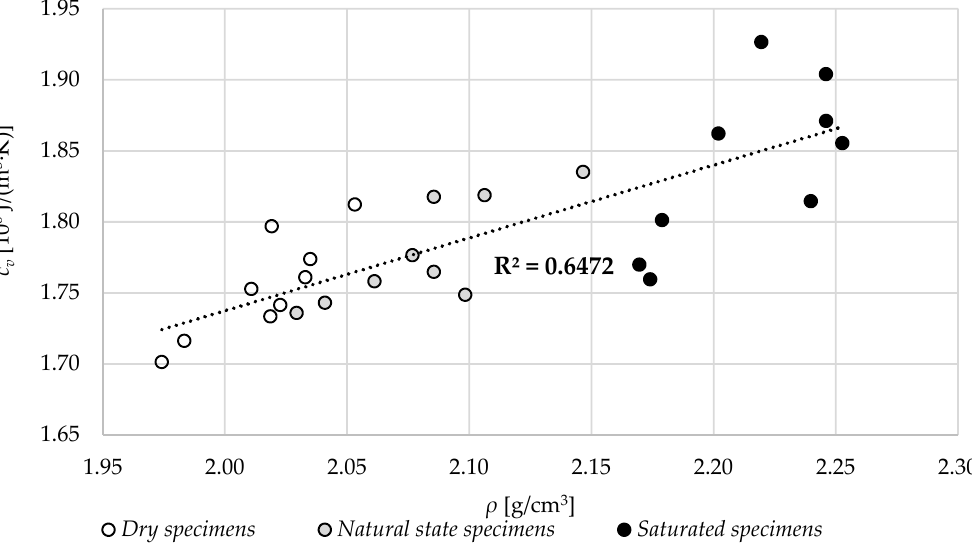
Figure 16. The relation between the volume density, ρ , in different specimen states and volume-specific heat, c v .